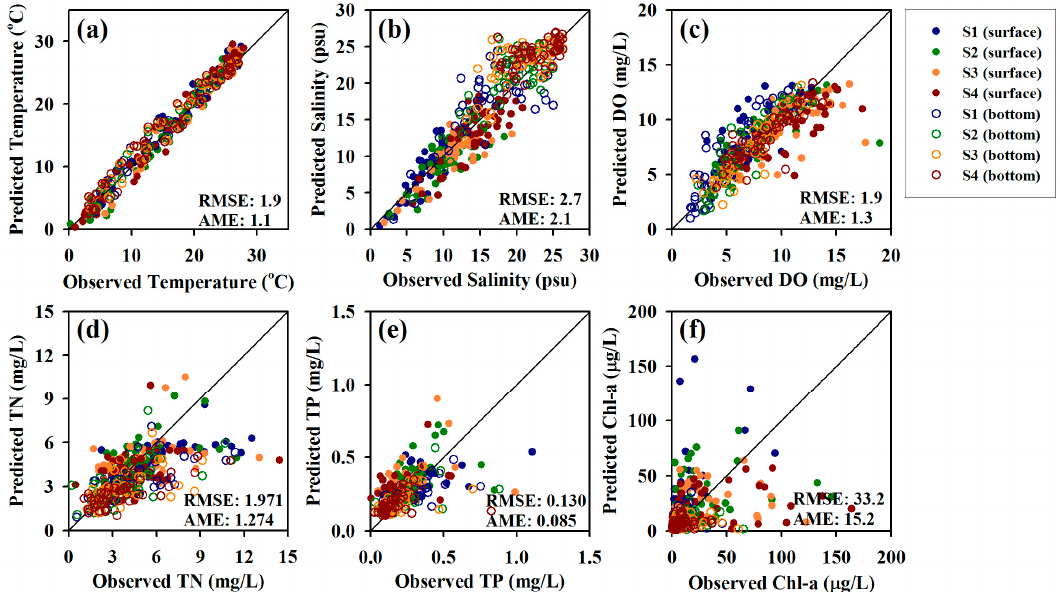
Figure 6. Comparisons of predicted and observed ( a ) temperature; ( b ) salinity; ( c ) DO; ( d ) TN; ( e ) TP; and ( f ) Chl-a.